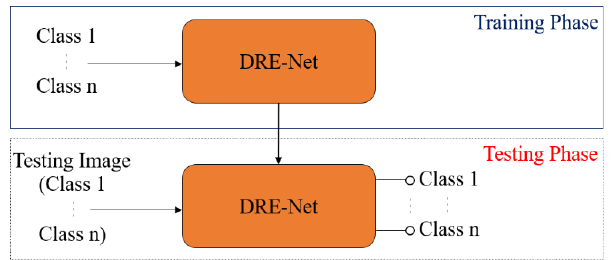
Figure 5. Diagram of closed-world configuration for classification.